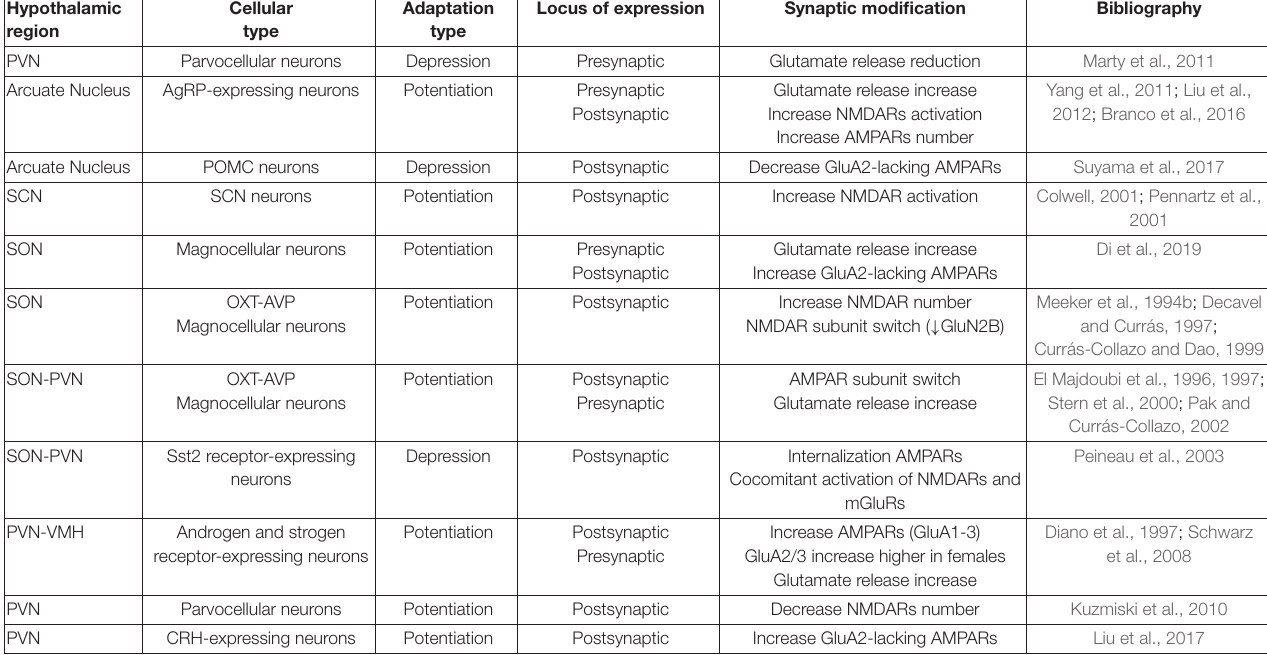
TABLE 1 | Summary of AMPAR and NMDAR modifications during plastic events reported in the